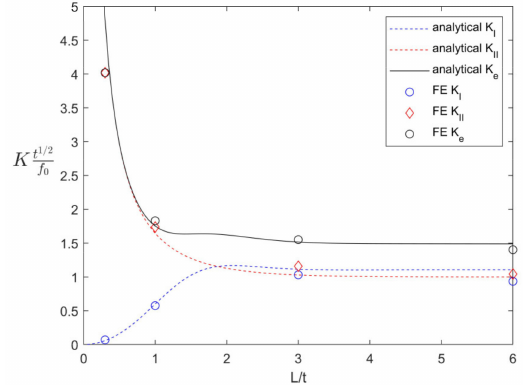
Figure 11. The SIF results: the analytical versus FE solutions for the lap-shear test